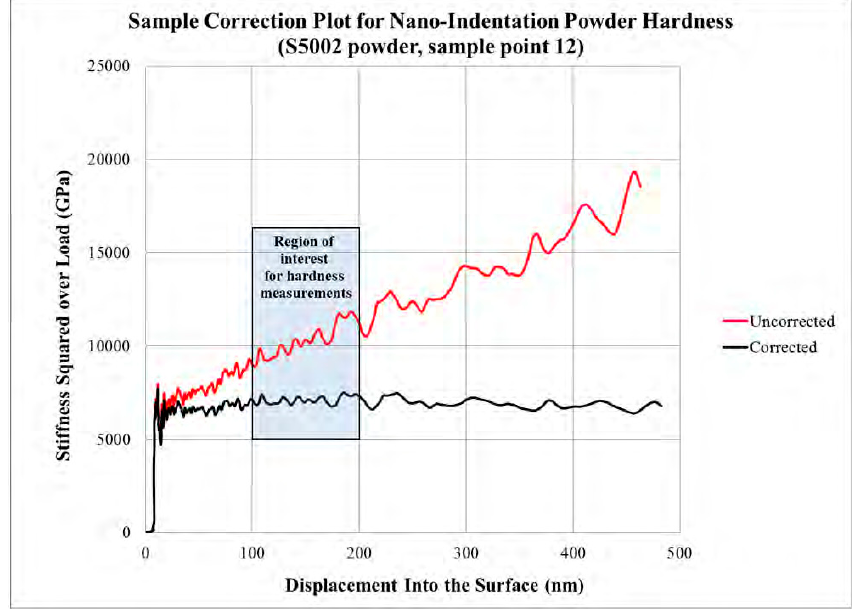
Figure 4. Stiffness squared per load vs. indentation depth curve demonstrating the way in which the compliancy of a particle-matrix system may be identified from the experimentally collected nanoindentation data may be analyzed to predict particle immersion from graphical analysis. This figure was adopted from the publicly available work of Schiel in [44]. Interestingly, in comparison with Figure 3 ( Right ), which concerns the use of a compression mounting matrix, the use of a castable mounting epoxy (by Schiel) introduced much greater compliancy at much smaller depths.